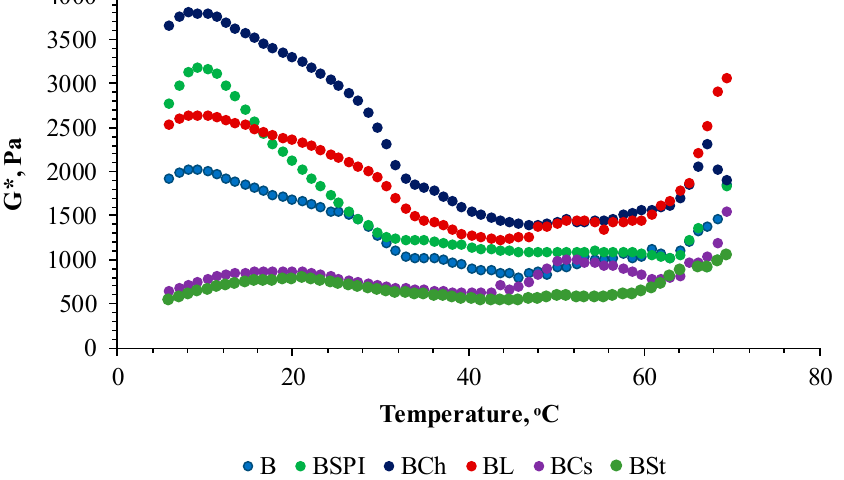
Figure 1. The effect of different non-meat ingredients on rheological behavior of beef emulsions during small amplitude oscillatory temperature ramp test. B—control sample (no additions); BCh—beef emulsion with chickpea flour; BL—beef emulsion with lupine concentrate; BSPI—beef emulsion with soy protein isolate; BCs—beef emulsion with sodium caseinate; BSt—beef emulsion with